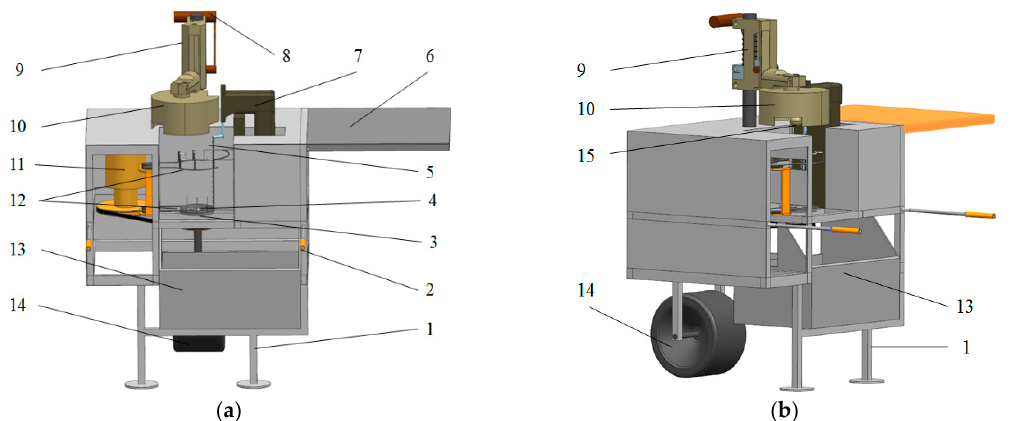
Figure 1. ( a ) Overall structure of harvester for Auricularia auricula . (1) Frame; (2) Push handle; (3) Tray; (4) Protrusion; (5) Harvesting knife; (6) Platform; (7) Harvesting device; (8) Pressing handle; (9) Rod pressing device; (10) Protective cover; (11) Tray motor; (12) Centralizing device; (13) Collecting box; (14) Walking wheel; and (15) Positioning beads. ( b ) Overall structure of harvester for Auricularia auricula . (1) Frame; (9) Rod pressing device; (10) Protective cover; (13) Collecting box; (14) Walking